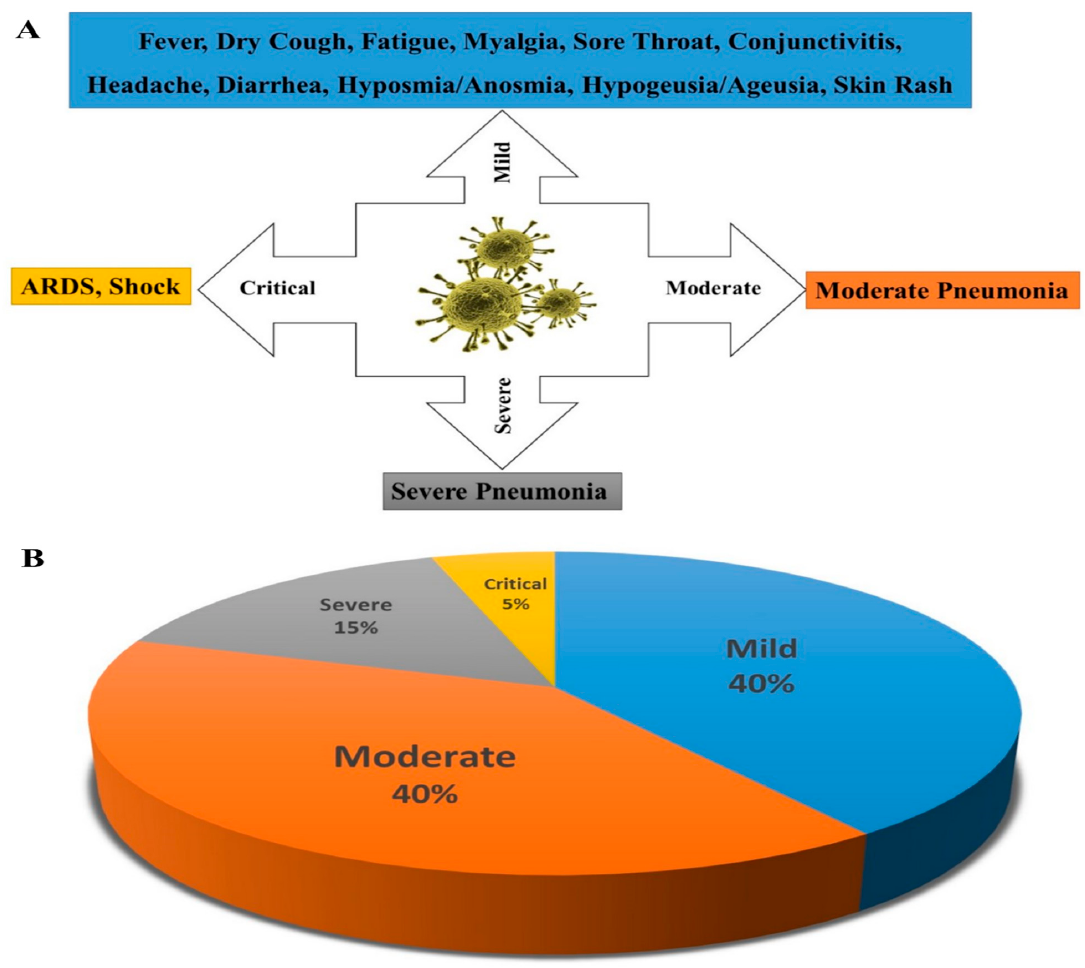
Figure 2. The clinical manifestations of symptomatic COVID-19 ( A ) and its prevalence ( B ).